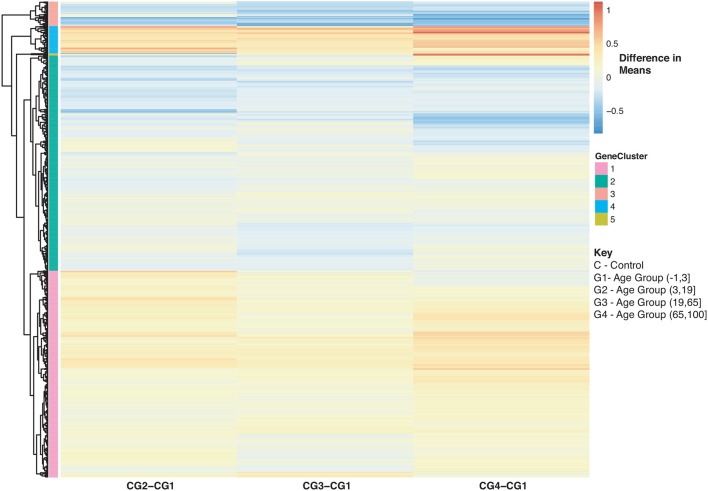
Heatmap of Statistically Significant (Bonferroni-adjusted p < 0.05) Genes with an Interaction Between Disease State and Age for Healthy Controls. Difference in means calculated by comparing control subjects in age groups 2–4 to control subjects in age group 1 (baseline).